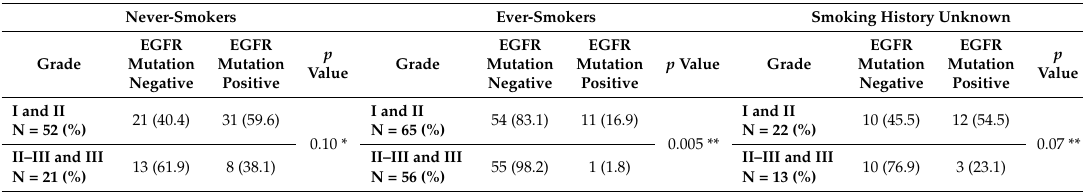
Table 5. Incidence of EGFR mutation by histologic grade and by smoking status in patients with metastatic lung